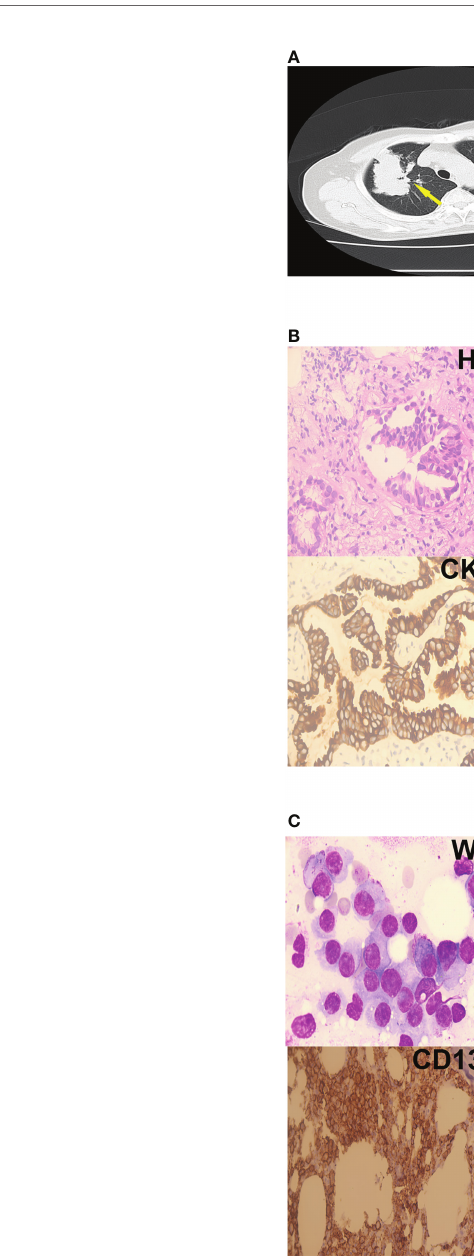
FIGURE 2 | Case 2. (A) Lung mass (yellow arrows) on chest computed mass, cross-section. (B) Adenocarcinoma cells were present in the right lung nodule (hematoxylin-eosin staining, 400×). Immunohistochemistry revealed that the tumor cells were TIF-1-positive, Napsin-positive, CK7-positive, CK5/6-negative, and P40- negative. (C) Plasma cells were present in the bone marrow aspirates and biopsy specimens (Wright staining, 1000×; hematoxylin-eosin staining, 200×). Immunohistochemistry revealed that the plasma cells were CD38-positive, CD138-positive, kappa-positive, and